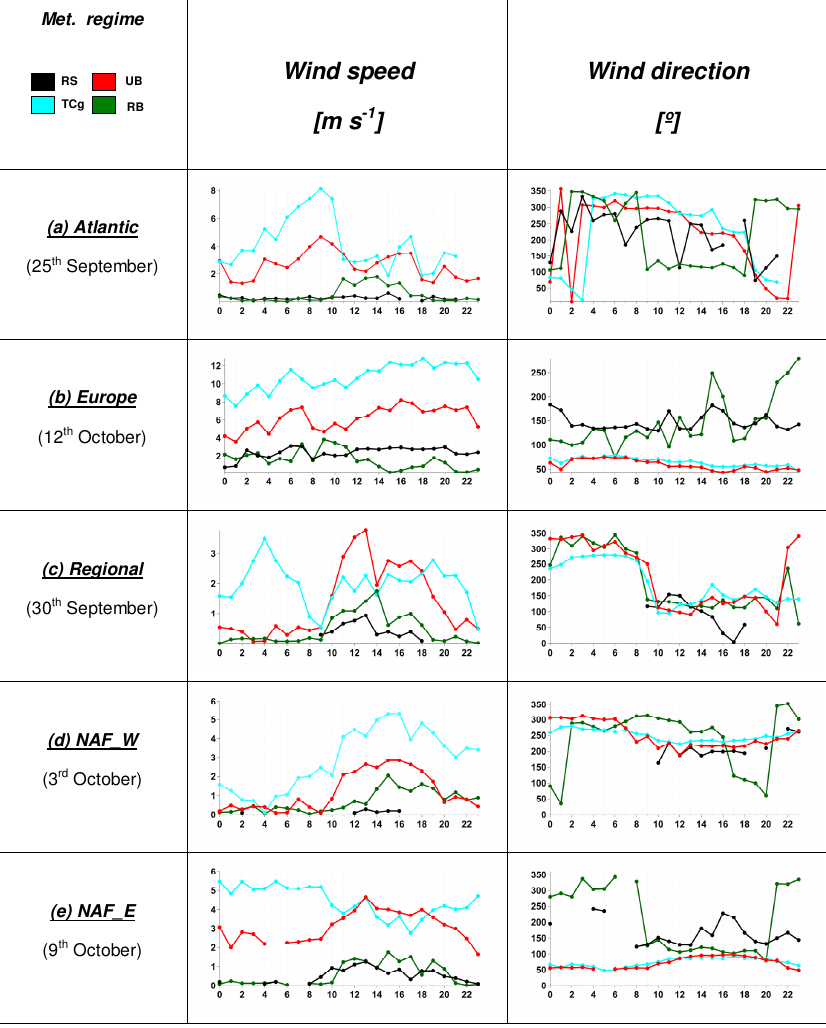
Fig. 7. Diurnal WS and WD average measurements at four SAPUSS monitoring sites under different air mass